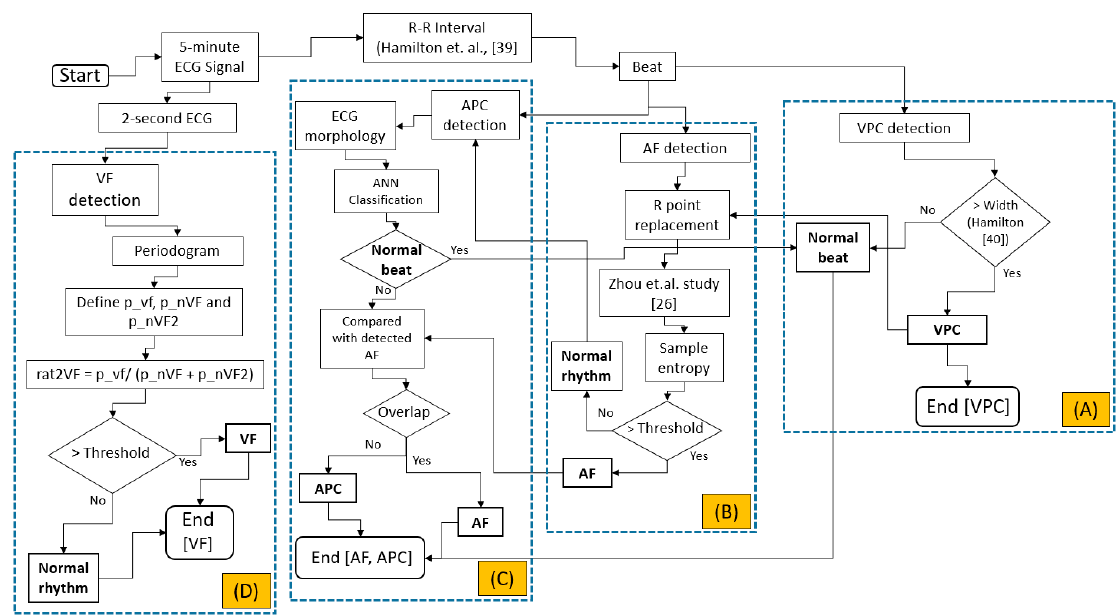
Figure 2. Integrated arrhythmia evaluation flowchart; ( A ) Ventricular premature complex detection; ( B ) Atrial fibrillation detection; ( C ) Atrial premature complex detection; ( D ) Ventricular fibrillation detection.